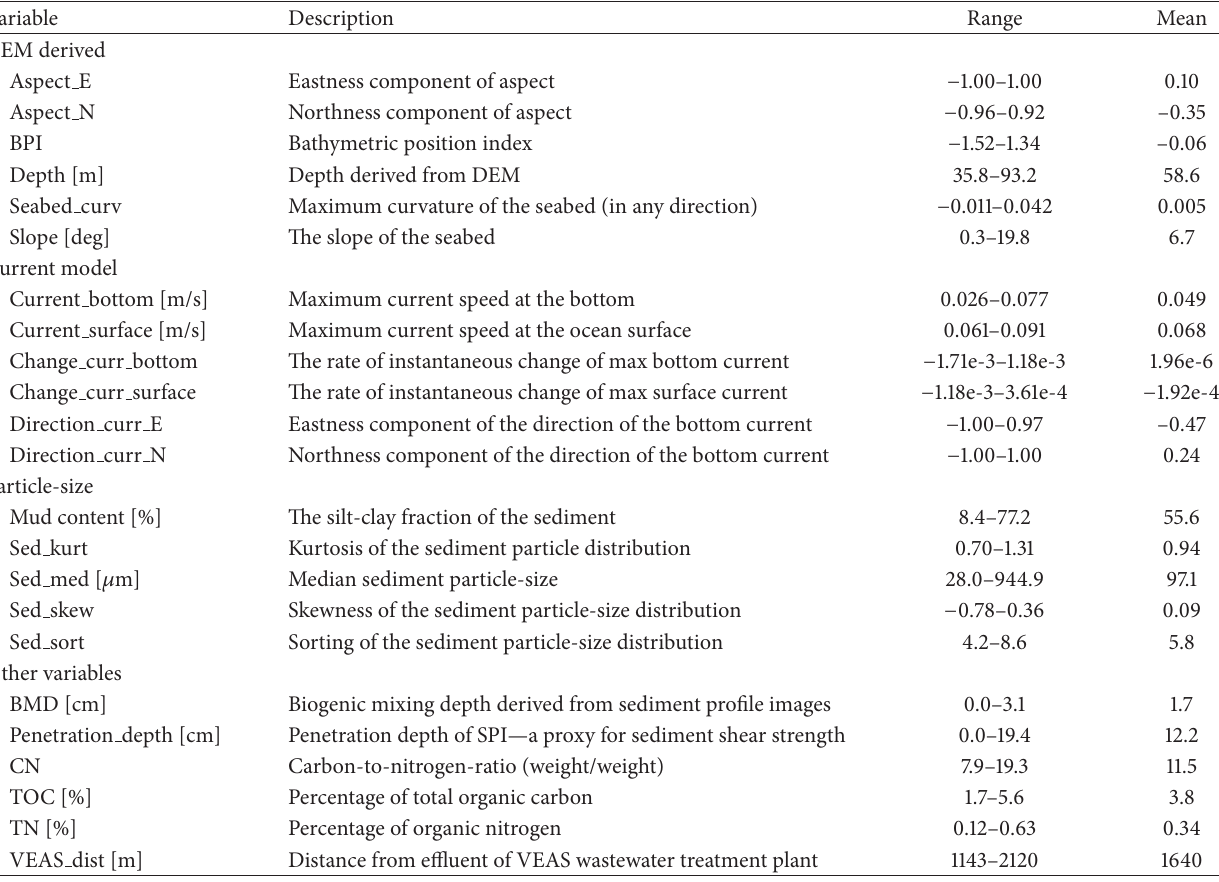
Table 2: Recorded environmental variables: group affiliation, name, description, range, and mean (of raw, untransformed